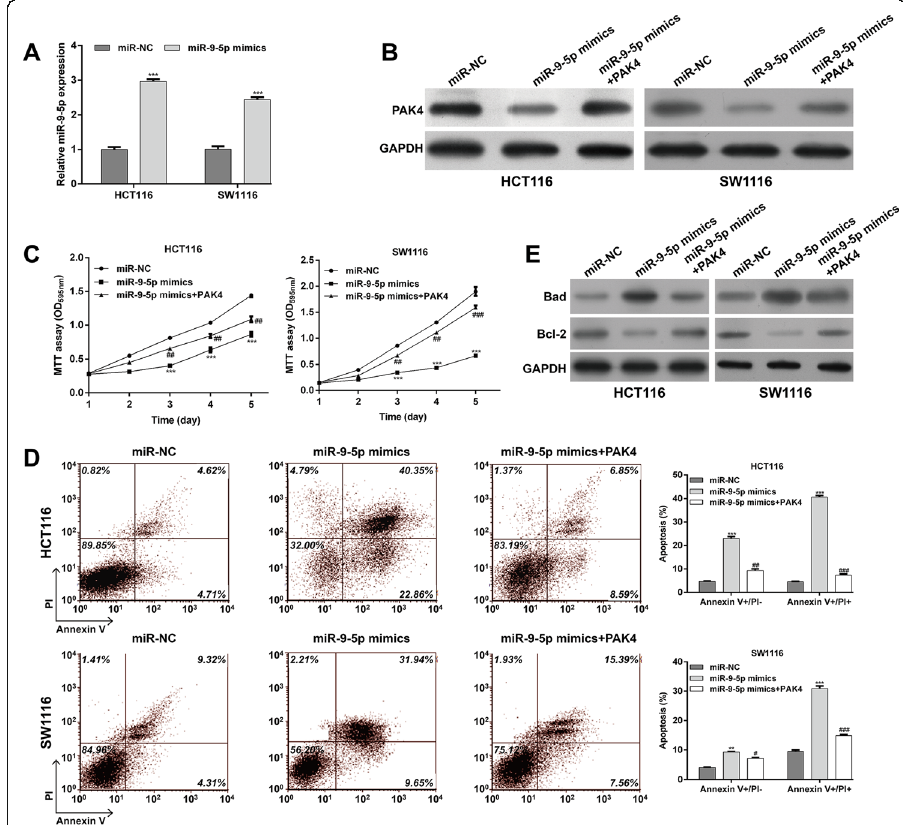
Fig. 5 PAK4 alleviated the effects of miR-9-5p on cell proliferation and apoptosis in CRC cells. HCT116 and SW1116 cells were transfected with miR-NC, miR-9-5p mimics or miR-9-5p mimics + PAK4 for 48 h. a Quantitative real-time PCR was used to determine miR-9-5p expression with U6 as internal control. b Western blot was used to determine the expression levels of PAK4 with GAPDH as a loading control. c MTT assay was utilized to determine the cell proliferation in different groups on consecutive 5 days. d Cell apoptosis levels were determined using flow cytometry. Representative images of double Annexin V/PI staining are shown in the left panel and a statistical analysis of early and late apoptotic cells is shown in the right panel. e The protein levels of Bad and Bcl-2 were detected using western blotting in both HCT116 and SW1116 cells. All data are expressed as the means ± SD. *** p < 0.001, compared with the miR-NC group; # p < 0.05, ## p < 0.01, ### p < 0.001, compared with the miR-9-5p mimics